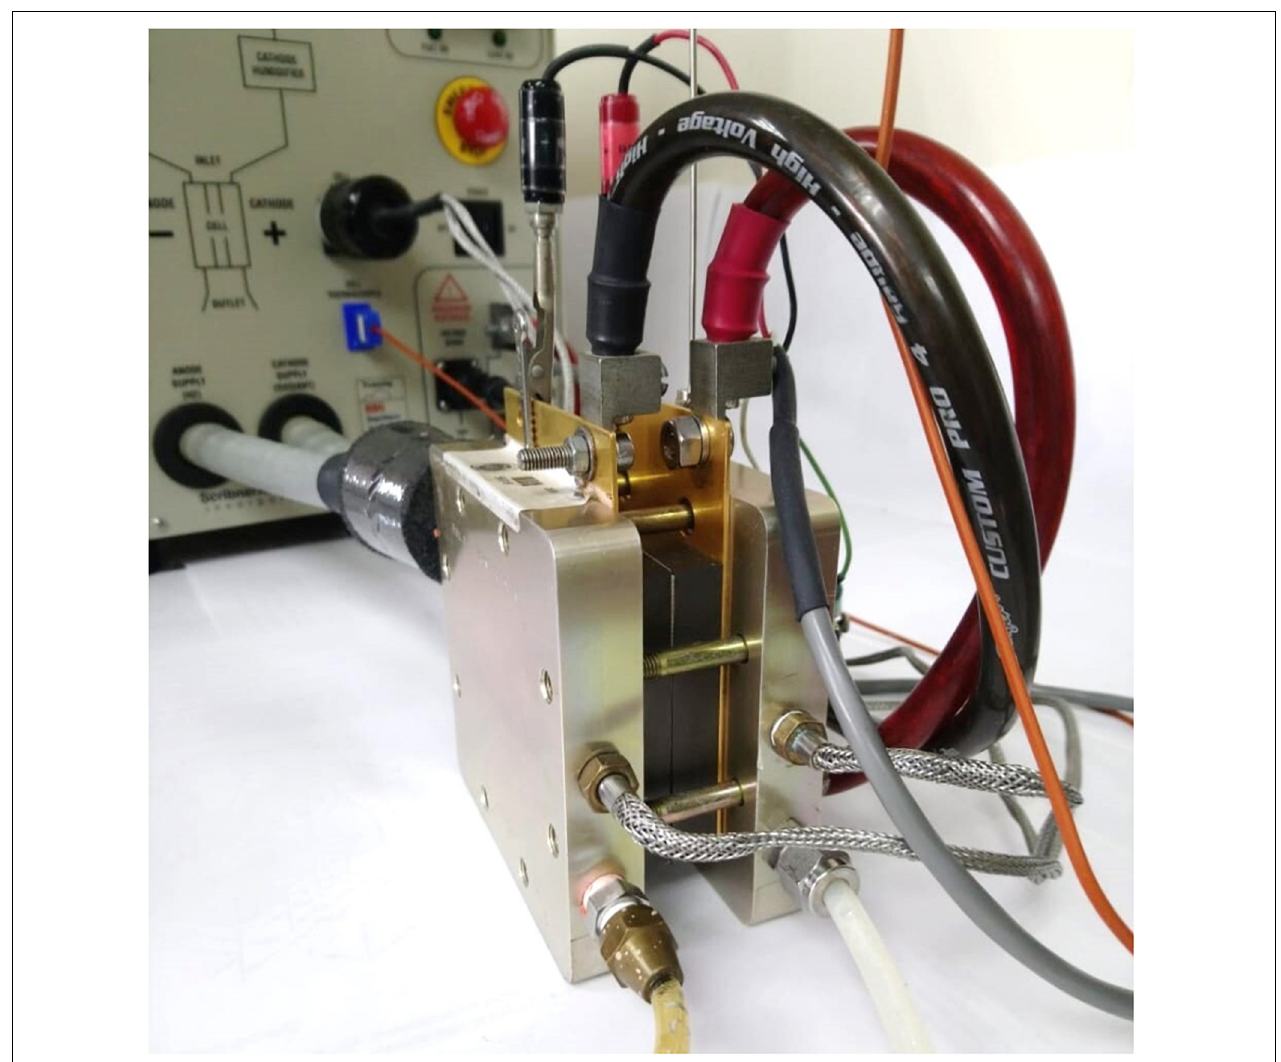
FIGURE 2 | Picture of the single PEFC used in this study with the required connections for data collection.